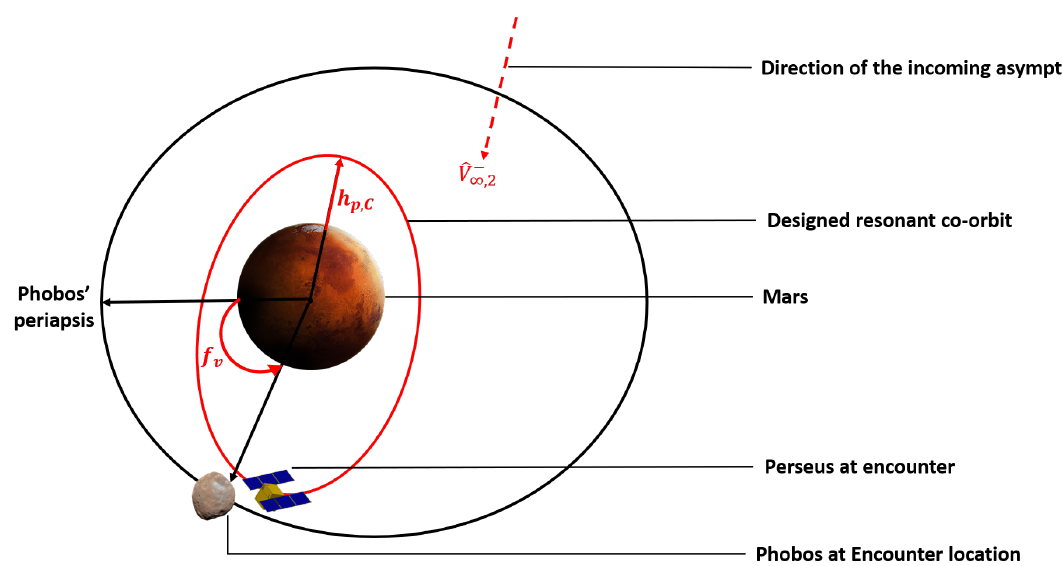
Figure 7. Illustration of the co-orbital mission concept highlighting the orbital parameters involved in designing the resonant co-orbit.